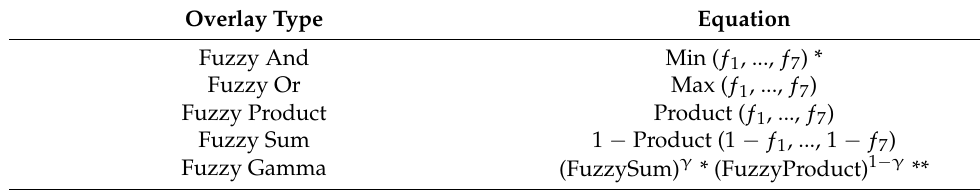
Figure 2. DRASTIC vulnerability map (after reference [4]). Table 1. Fuzzy Overlays in